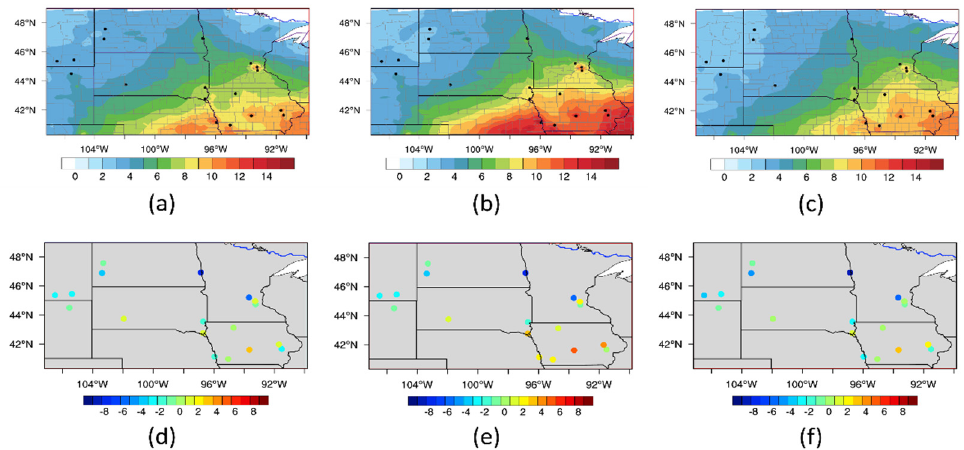
Figure 8. Monthly average of predicted hourly PM2.5 concentrations ( µ g/m 3 ) during July 2010. Model predictions for ( a ) RACM-MADE/SORGAM (RM), ( b ) CBMZ-MOSAIC (CM), and ( c ) MOZART-MOSAIC (MM). Mean bias of model predictions against observations for ( d ) RM, ( e ) CM, and ( f ) MM.